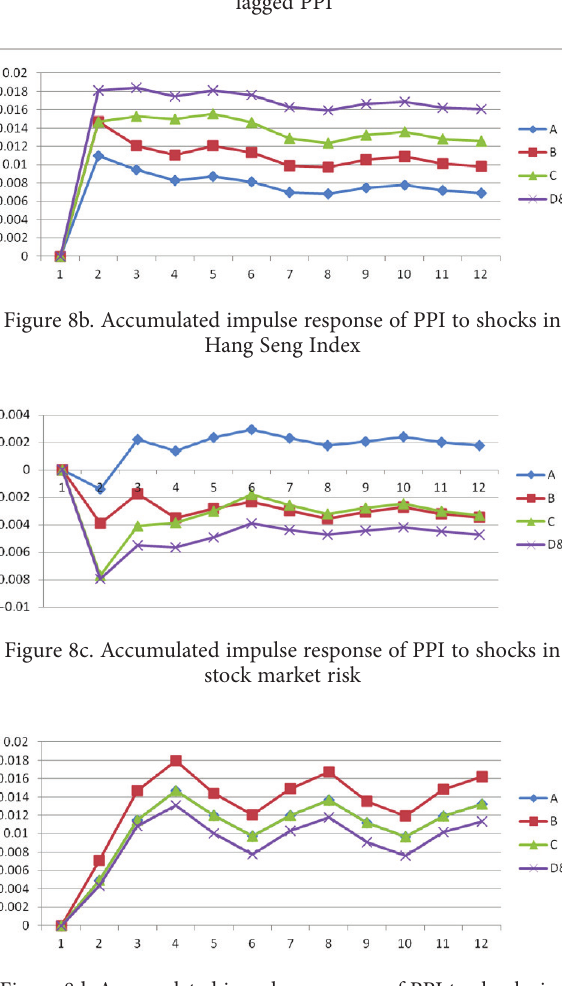
Figure 8i. Accumulated impulse response of PPI to shocks in money supply